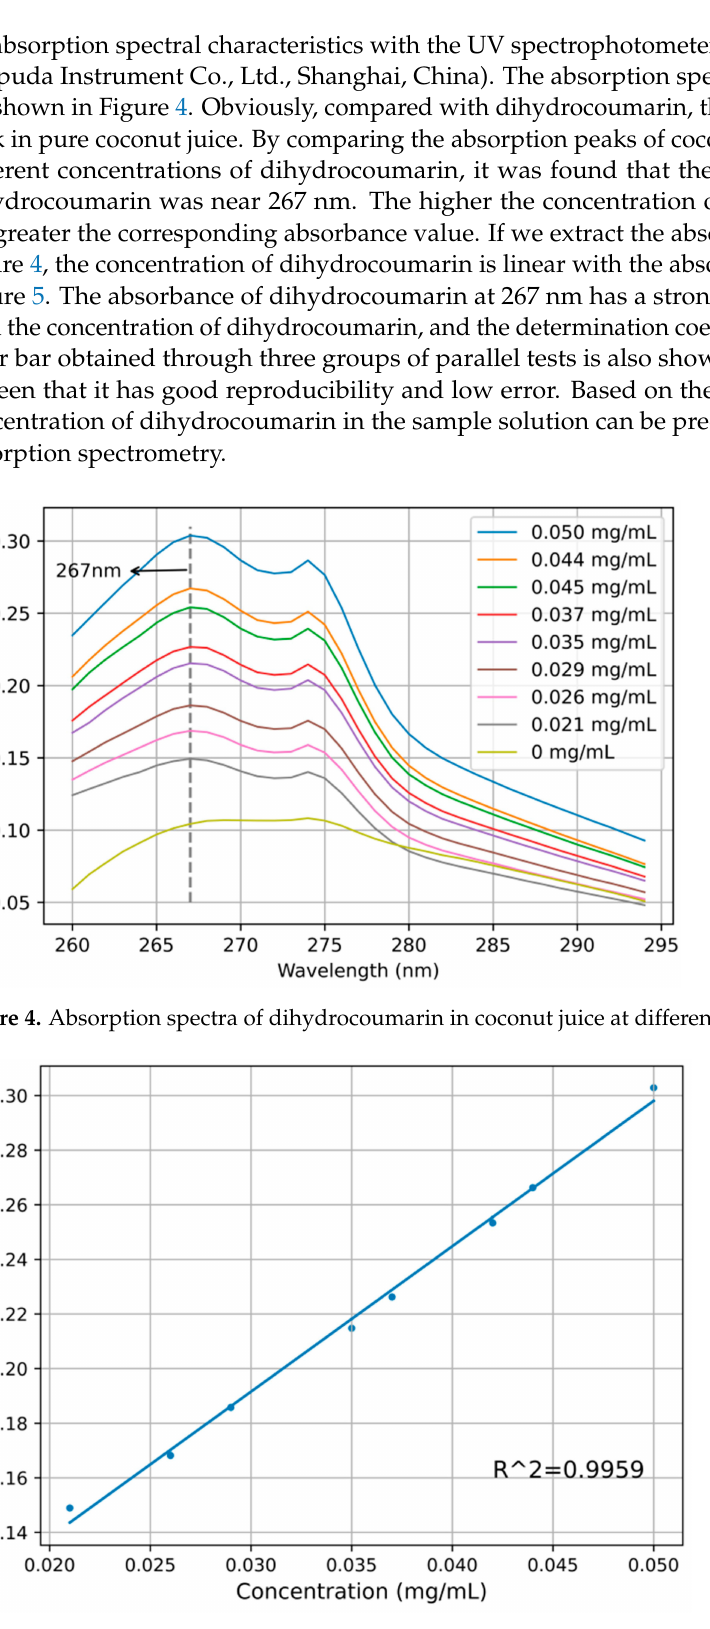
Figure 5. Relationship of dihydrocoumarin concentration and absorbance at 267